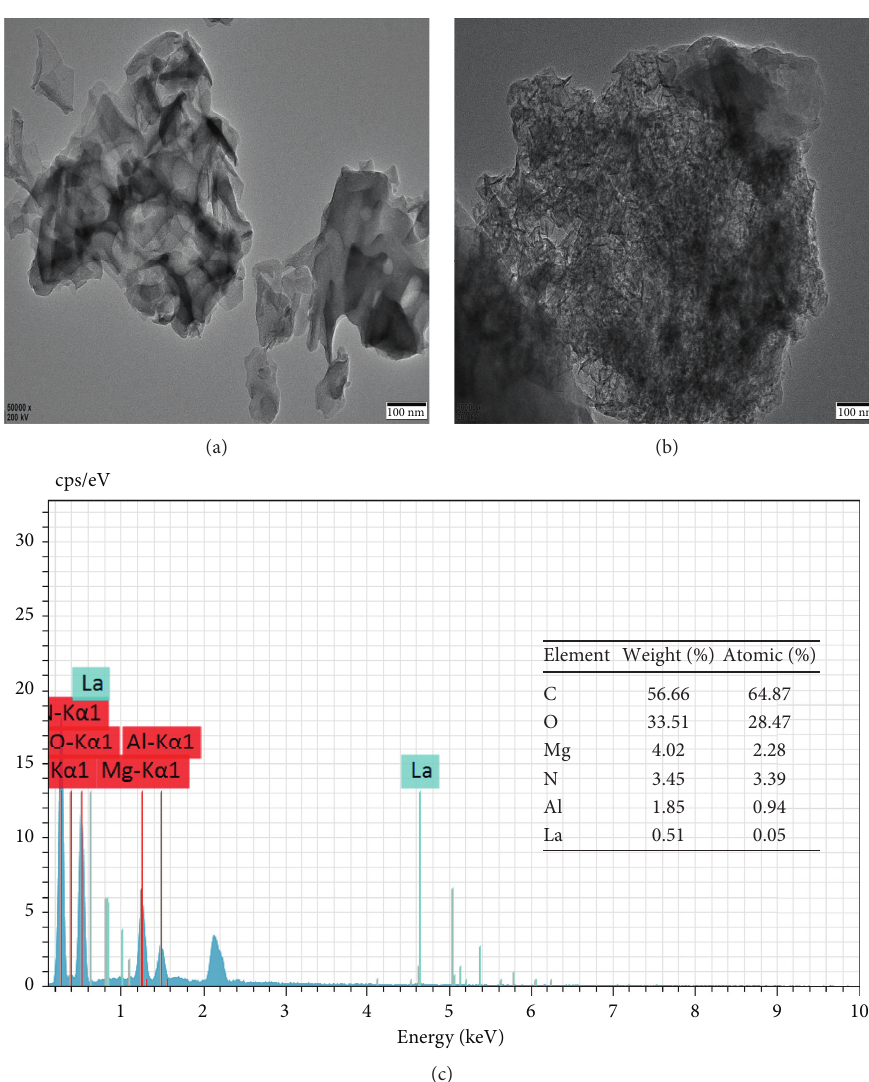
Figure 4: TEM images of (a) GO, (b) La LDH/GO, and (c) EDS analysis of La